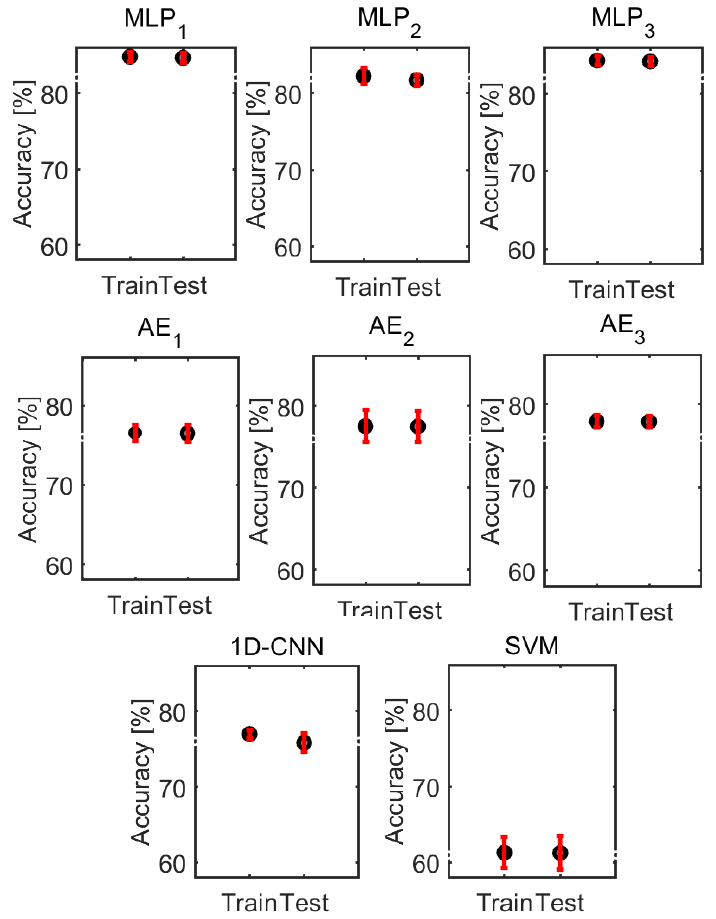
Figure 11. Accuracy values achieved on the train and test sets, for each developed classifier. The black dot represents the average accuracy, while the vertical red line denotes the standard